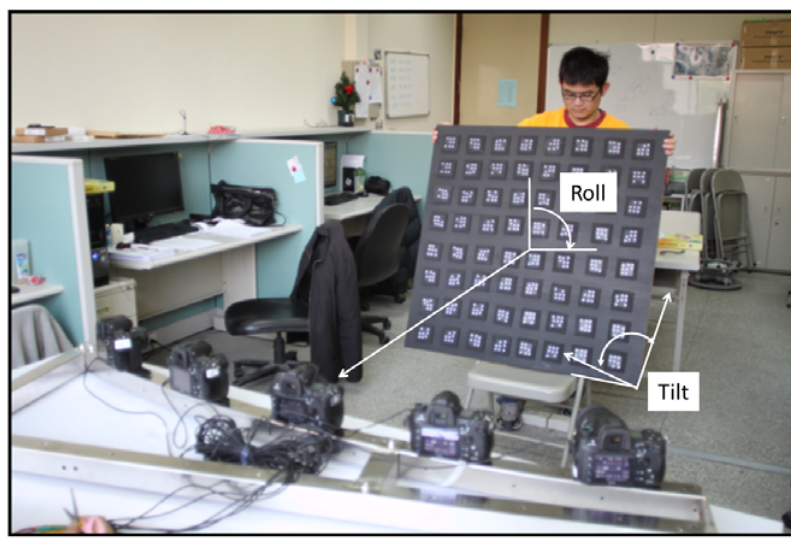
Figure 6. Taking pictures for multi-camera